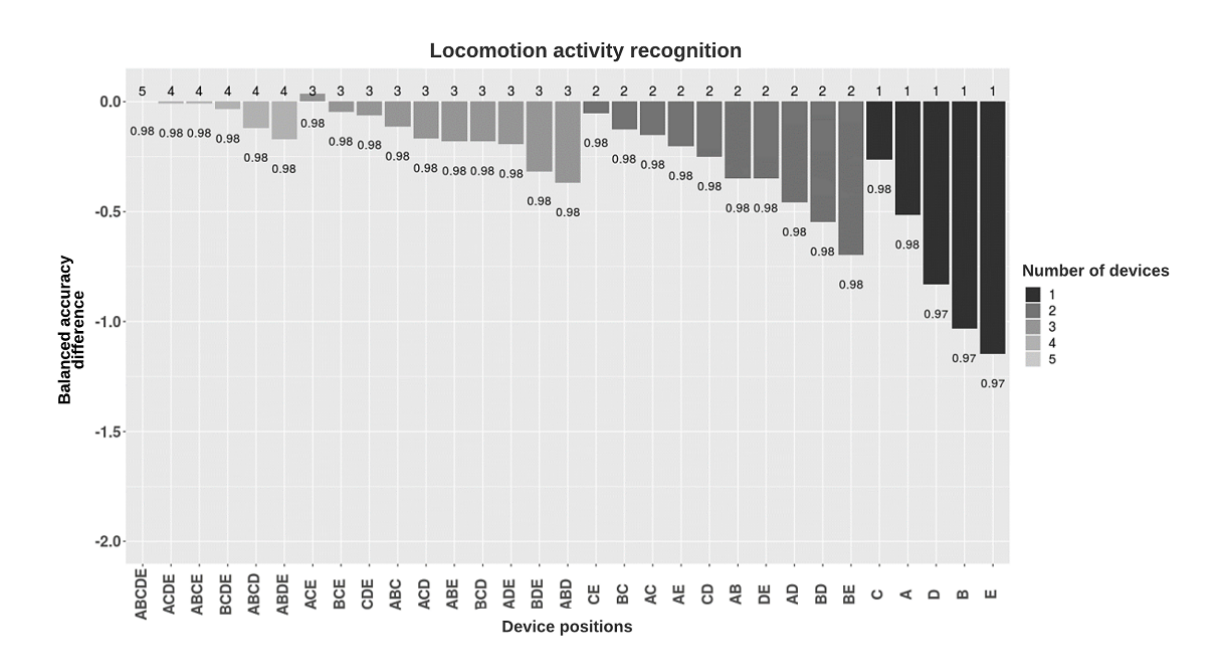
Figure 4. Balanced accuracy performance of locomotion activity classification models based on the device placement combinations. Models were grouped by the number of devices used and, in each group, were sorted in decreasing balanced accuracy (rounded). Y-axis shows the difference between the balanced accuracies of the different combinations and the five-placement combination. Numbers in the plot show the balanced accuracies of each placement combination. A: ankle; B: upper arm; C: hip; D: thigh; E: wrist.